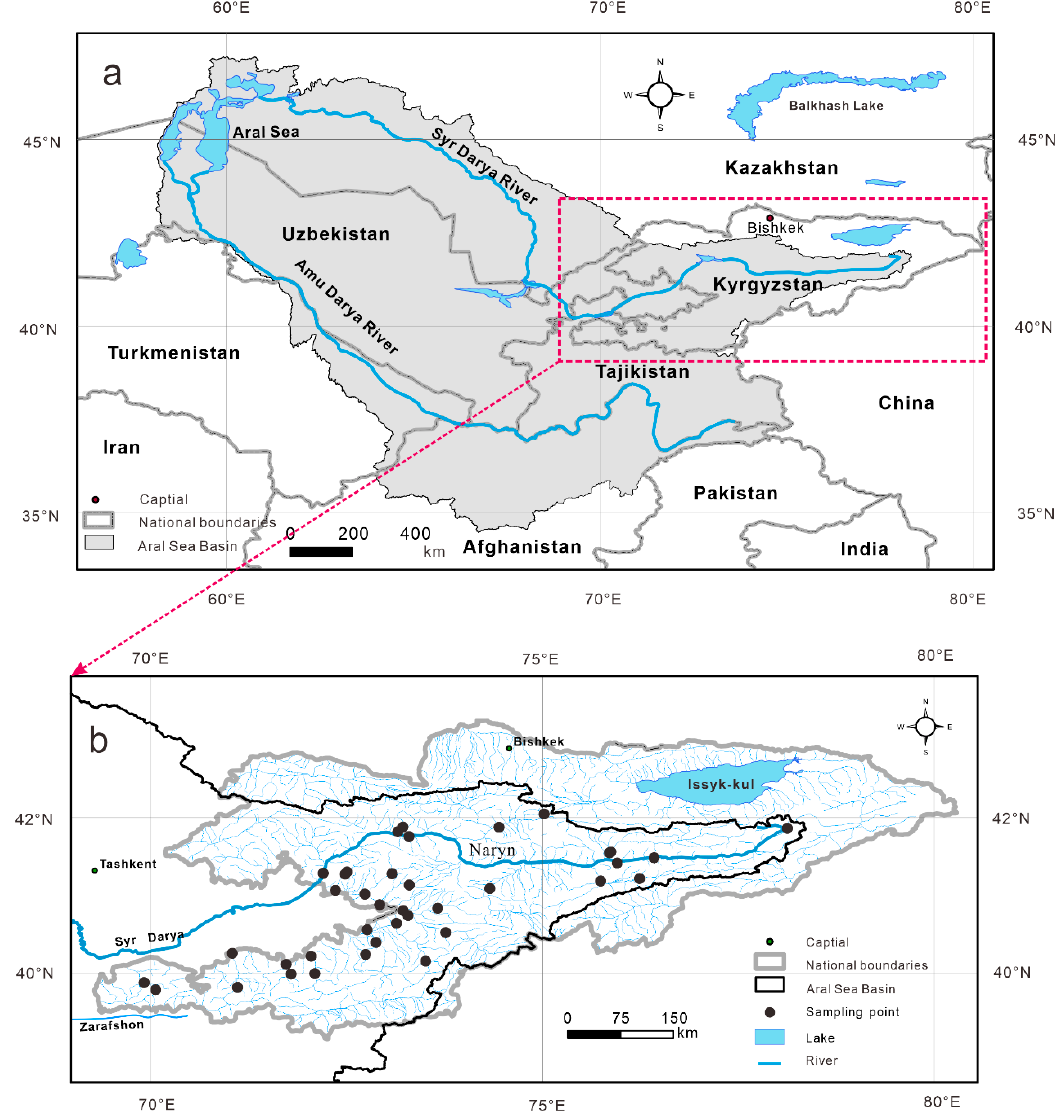
Figure 1. Geographical location of the study area ( a ) and distribution of the sampling points ( b ). The detailed information for sampling points is provided in the Supplementary Materials (Table S1).